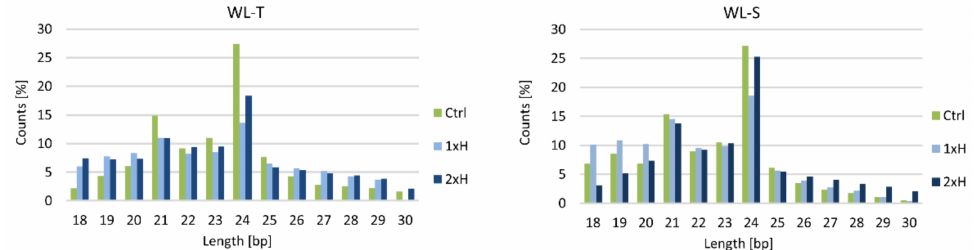
Figure 8. The length distribution for small RNA sequences WL-T and WL-S cucumber accessions of Ctrl, 1xH and 2xH experimental